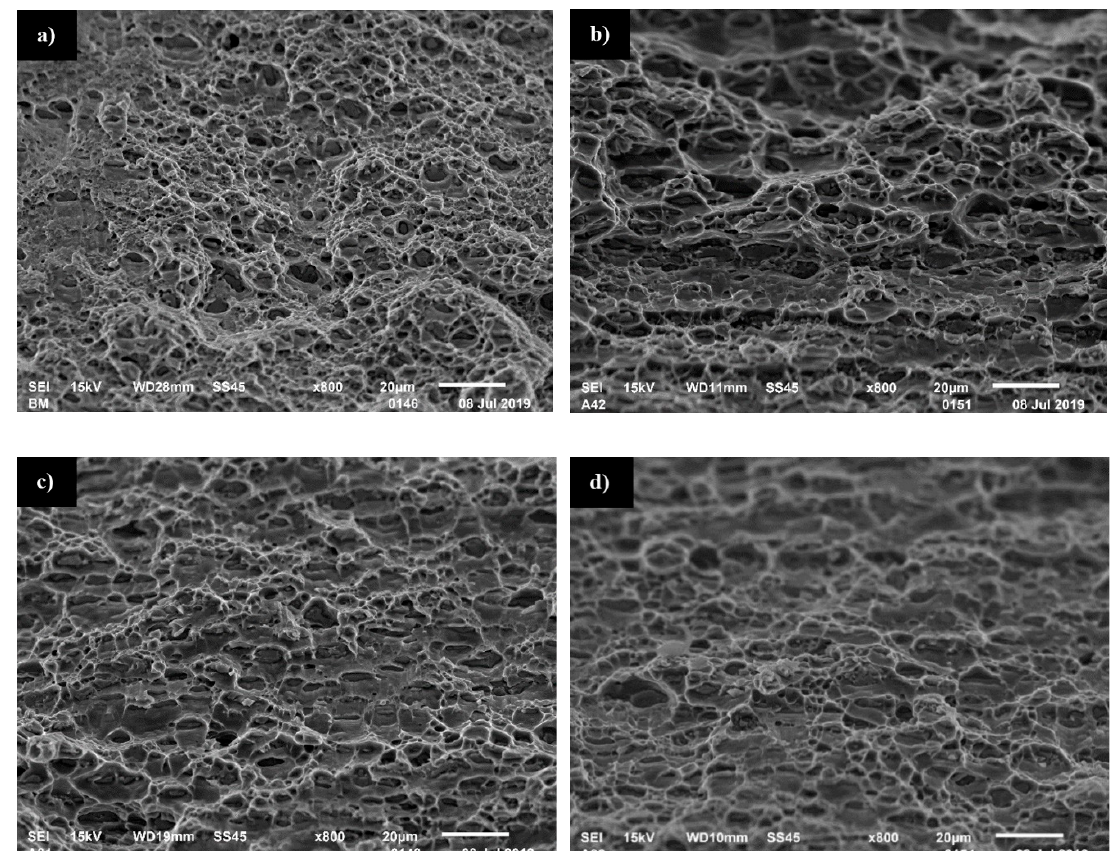
Figure 14. Scanning electron microscopy images of fracture surface of the ( a ) base material, ( b ) A42 sample, ( c ) A81 sample, and ( d ) A82 sample.